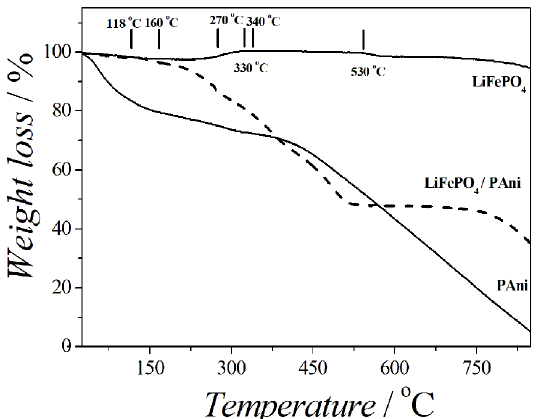
, PAni and LiFePO 4